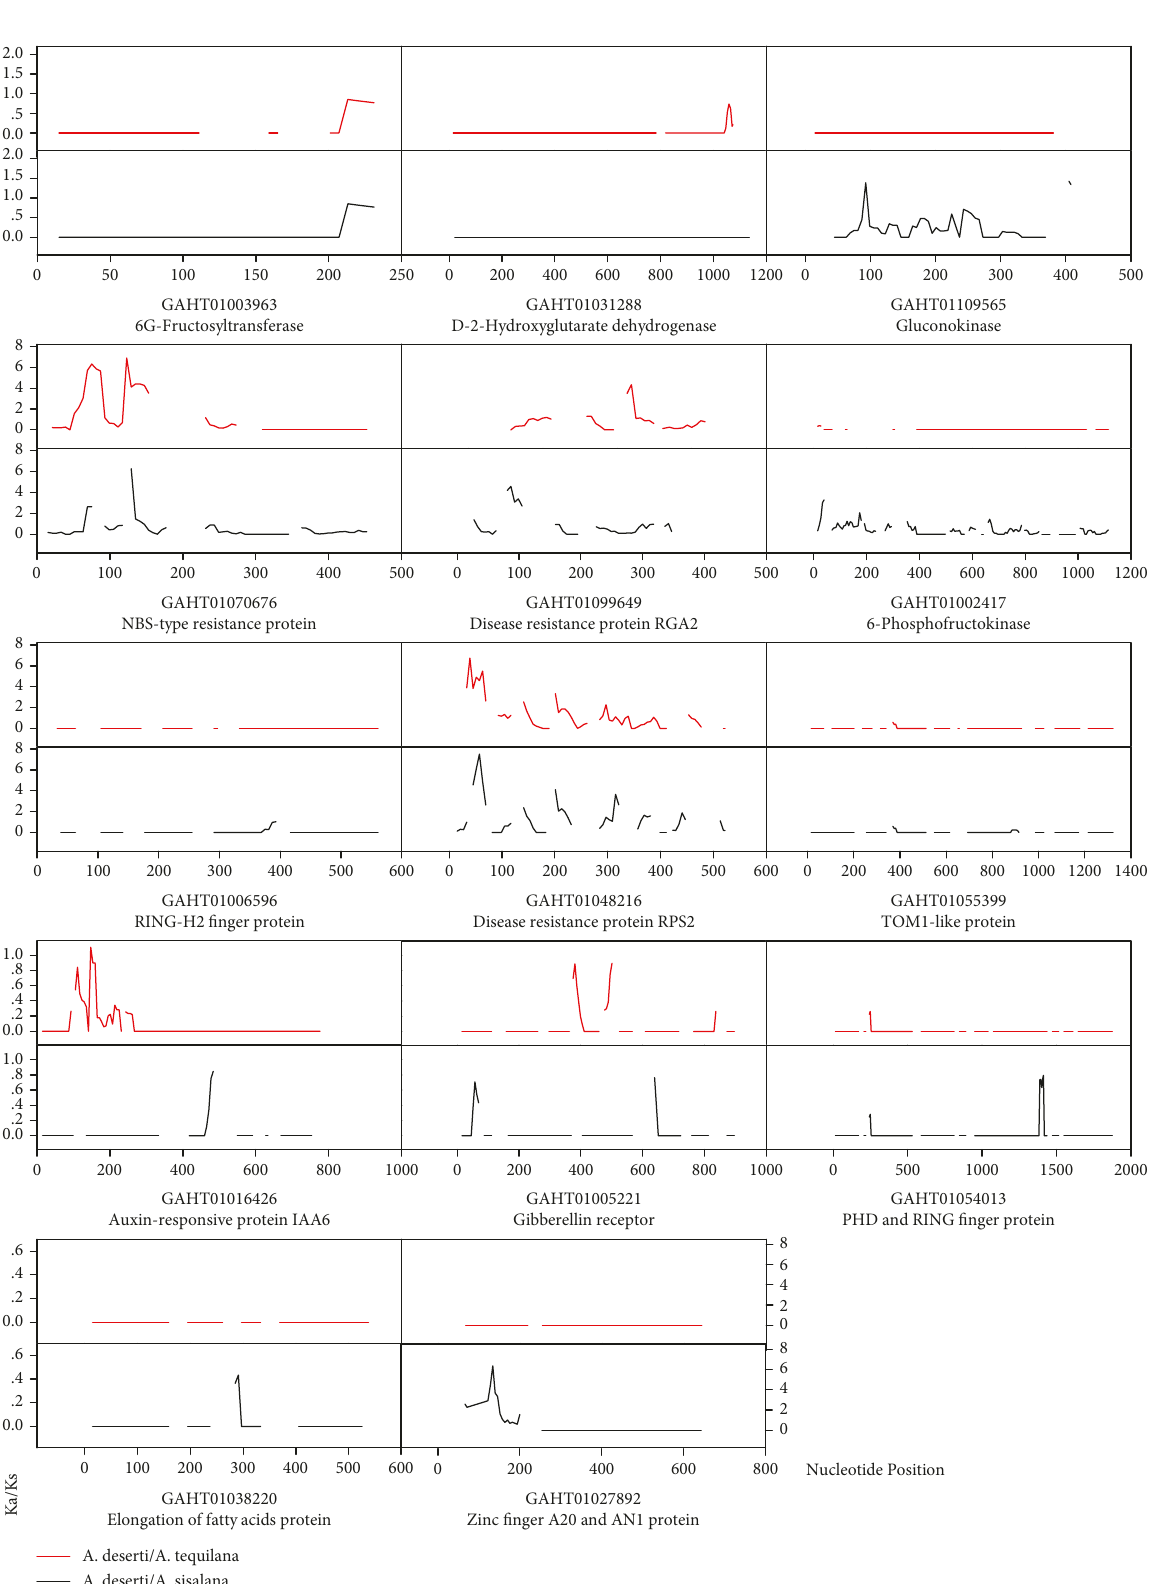
Figure 6: Sliding window analysis of positive selection unigenes in A. tequilana (red) and A. sisalana (black) compared with A. deserti , respectively. The window size is 30bp, with a step size of 6bp. The x -axis denotes the nucleotide position. The y -axis denotes the Ka/Ks ratio. The gaps represent Ka/Ks ratios that could not be